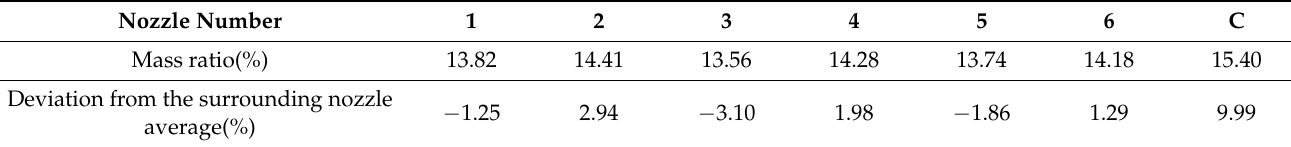
Table 1. Mass ratio of surrounding nozzles in the overall model’s